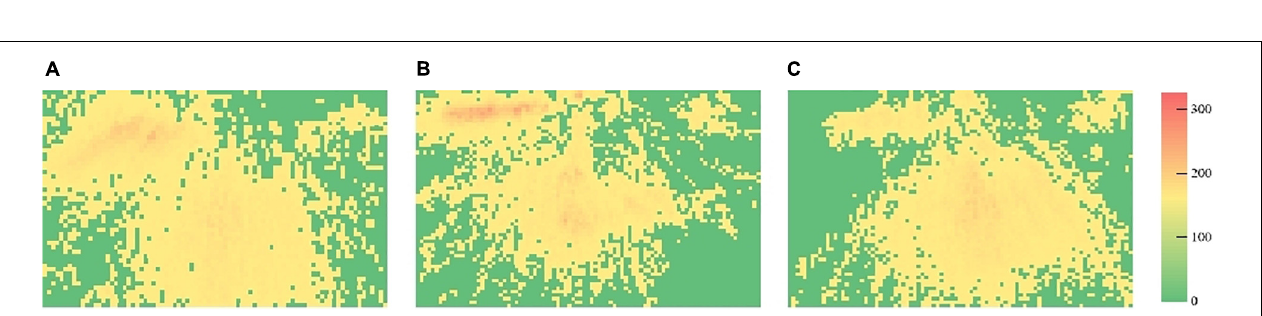
Frontiers in Psychiatry |